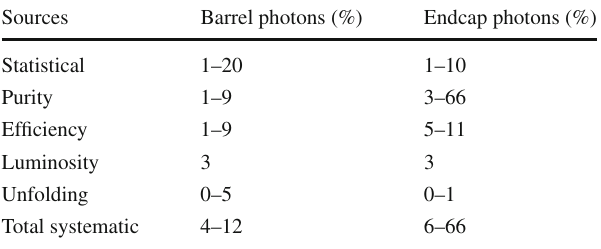
Table 2 Summary of the uncertainties in the measured cross section values for photons in the barrel (endcap)